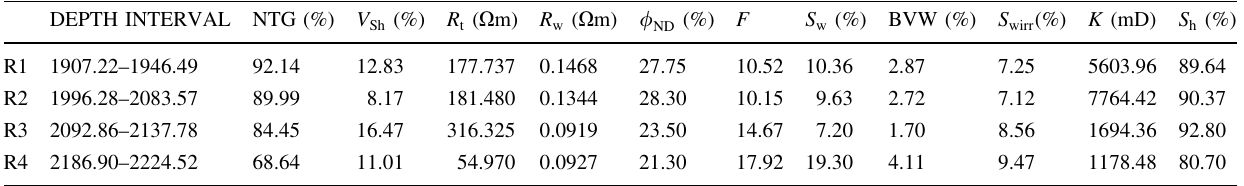
Table 2 Estimated petrophysical parameters at well